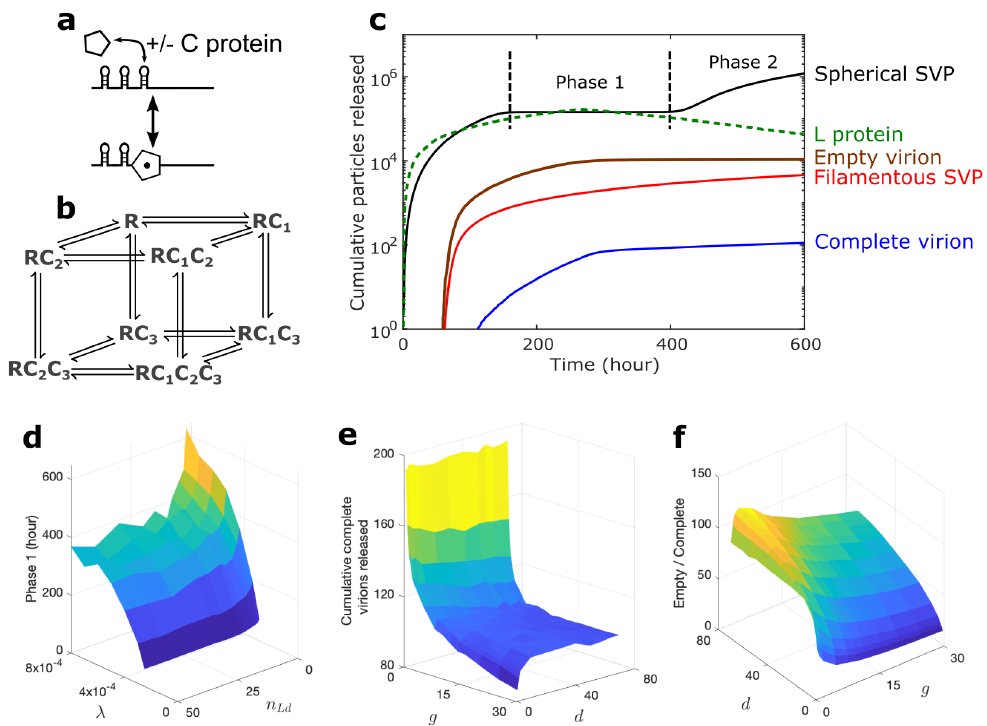
Figure 3. The release kinetics indicate a novel two-phase behaviour in the drug-free case. ( a ) The interaction between PSs and C proteins where C proteins bind and unbind to the RNP (R) complex. ( b ) All possible pathways to occupying all three PSs. ( c ) The time evolution of the model shows the cumulative number of released particles, averaged over 100 simulations. The 95%CI (the confidence interval, shown as shaded area around each curve) is included, but is not visible due to the small size and the logarithmic scale. This can be seen more clearly in Figure 5 and Figure S11. Phase 1 is the plateau in the release of spherical SVPs. The average number of RNA-containing particles released over 100 simulations is 0.1 (0.1 ± 0.07 95% CI), which is not visible here due to the scale, but is shown in Figure S11d. Although L protein does not get released, its concentration is plotted (green dashed line) to show the impact of L protein on the release of particles and the emergence of Phase 1. ( d ) The length of Phase 1 as a function of λ and n Ld (Supplementary Equations (S1) and (S3)). ( e ) The total number of complete virions released from an infected cell over 600 h after cccDNA formation. ( f ) The ratio of the number of empty virions over complete virions released over 600 h after cccDNA formation as a function of g , which is the binding rate of P protein to pgRNA, and d , which is the binding rate of the ribosome to the pgRNA (Supplementary Equation (S2)). This figure is plotted using parameter values from Supplementary Table